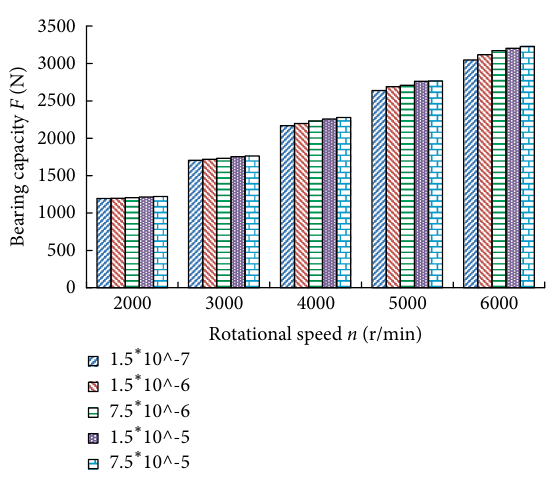
Figure 9: Effect of w g and rotational speed on oil film pressure